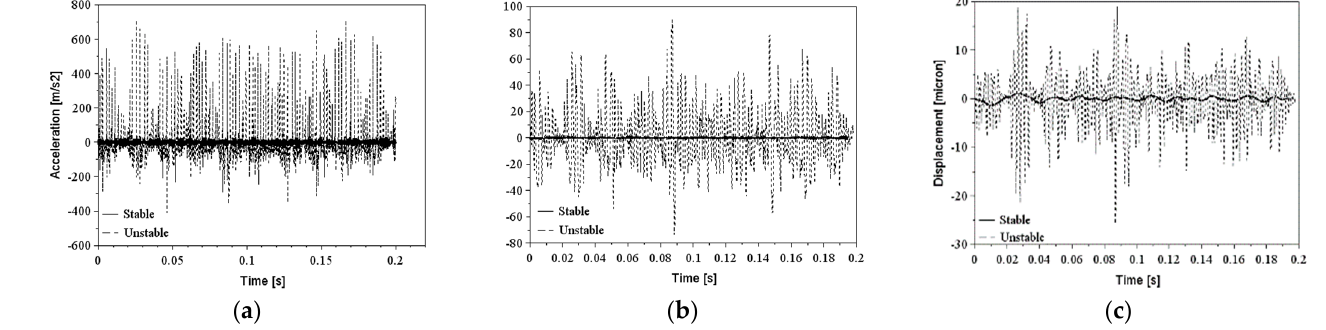
Figure 10. Excitation signals in stable TSC = 4 mm − 1 and unstable TSC = 7.81 mm − 1 conditions with a standard boring bar: ( a ) acceleration; ( b ) velocity; ( c ) displacement amplitudes.